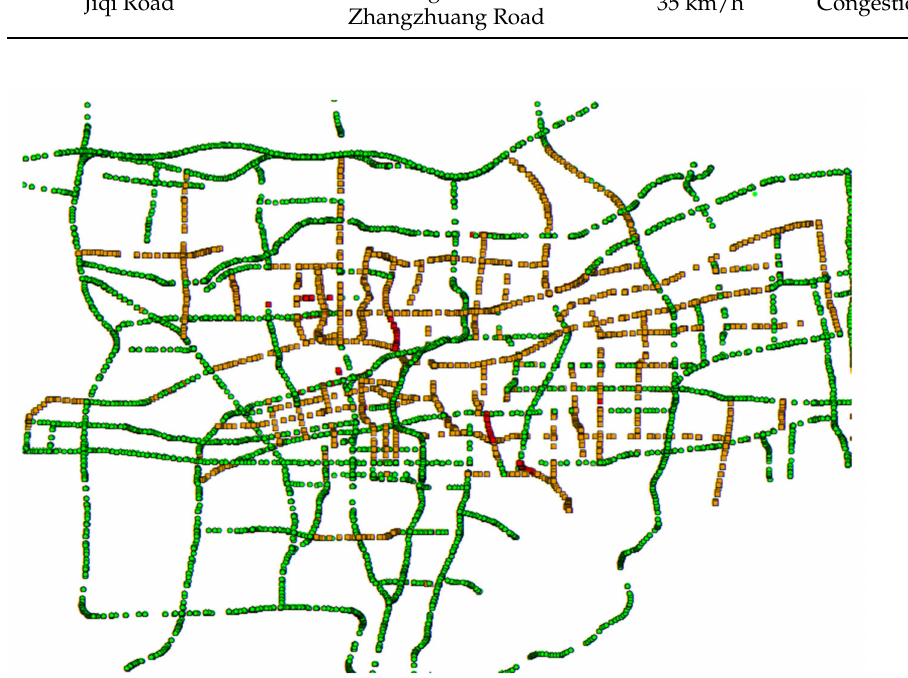
Figure 5. Road conditions at other times of weekdays. (The closer the road color is to green, the smoother the road. The closer the road color is to red, the more congested it